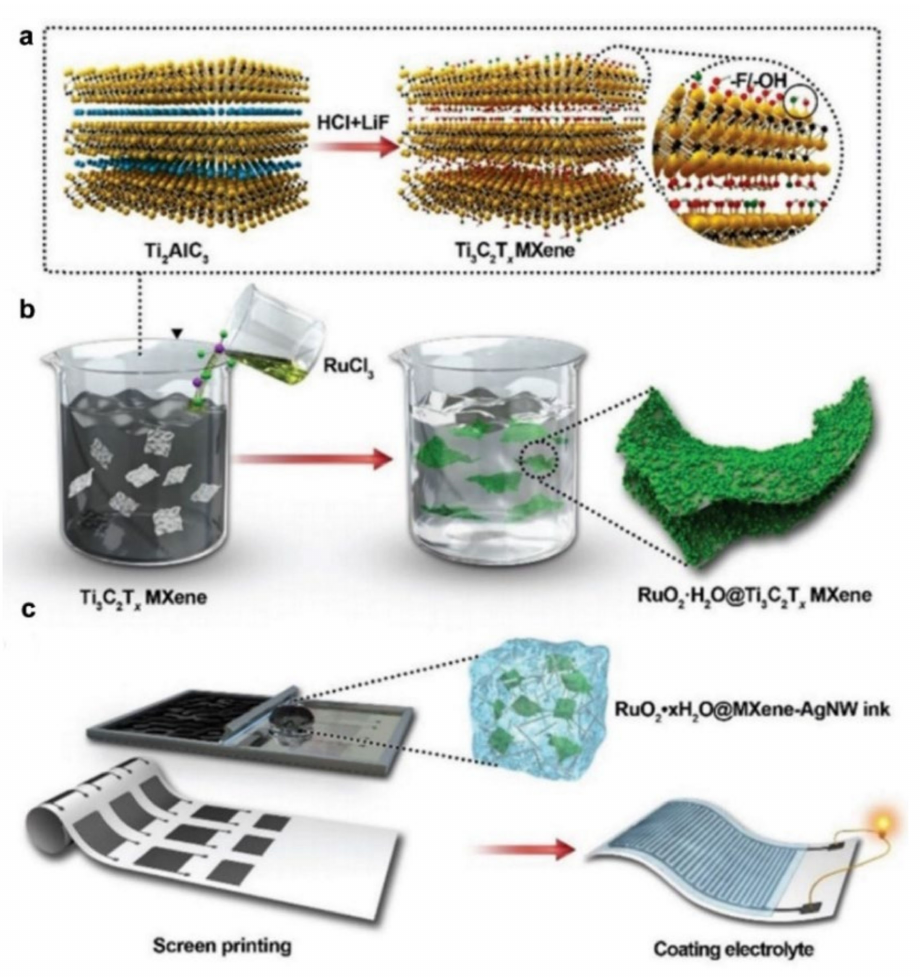
Figure 11. Schematic illustrating of ( a ) the preparation of MXene, ( b ) the synthesis process of the RuO 2 · xH 2 O@MXene nanohybrid, and ( c ) the screen-printing process for the fabrication of the flexible MXene-based MSCs